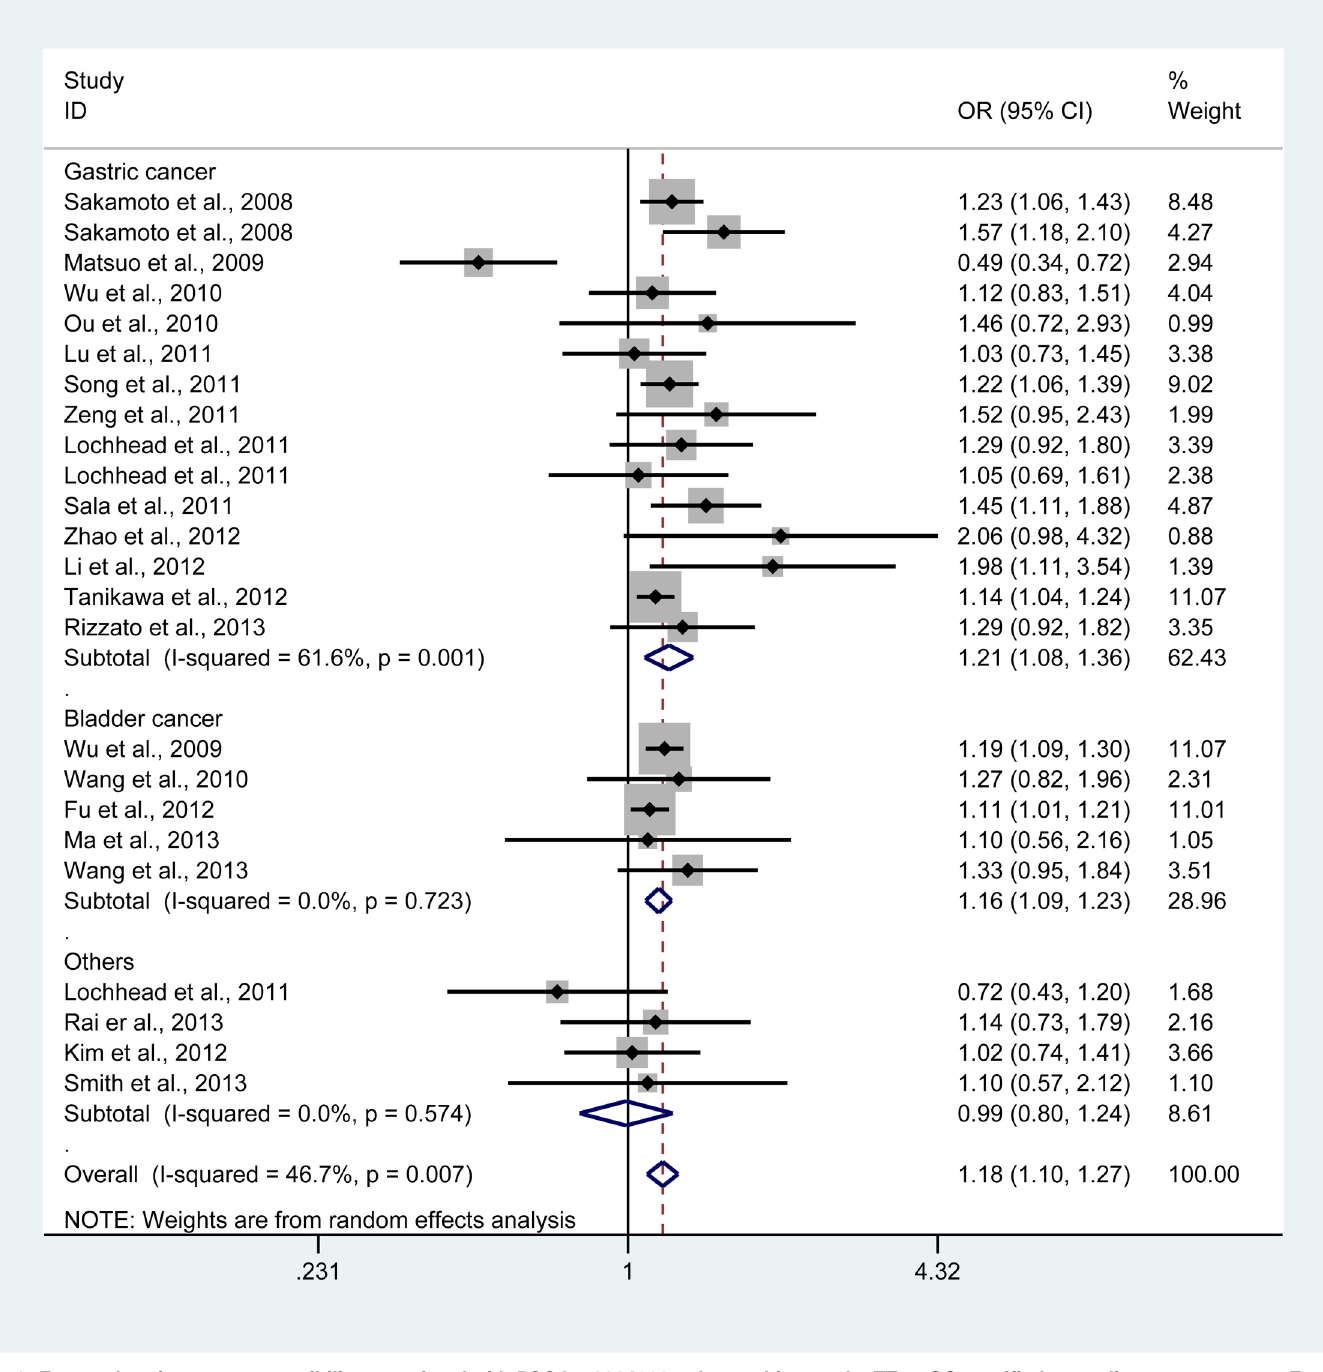
Fig 2. Forest plot of cancer susceptibility associated with PSCA rs2294008 polymorphism under TT vs CC stratified according to cancer type. For each study, the estimates of OR and its 95% CI were plotted with a box and a horizontal line. The symbol filled diamond indicates pooled OR and its 95% CI. Random effects meta-analysis shows a significant